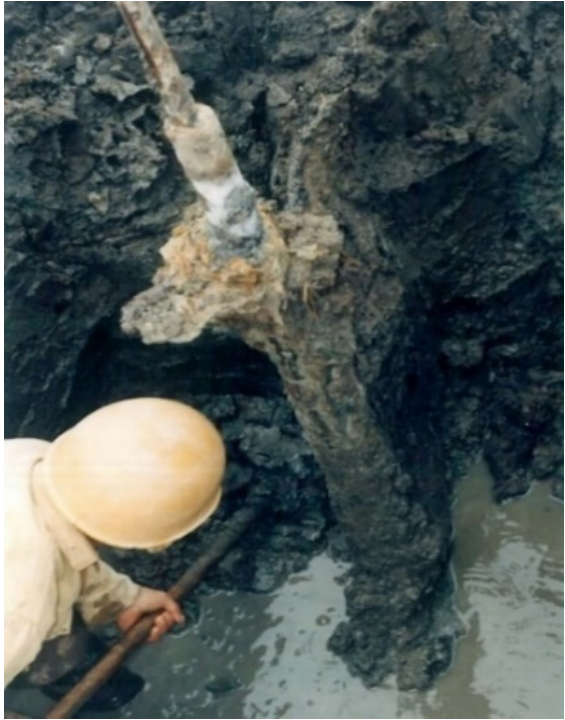
Figure 2. Single bar reinforced micropile after the first phase of pressure grouting using a sleeve pipe.